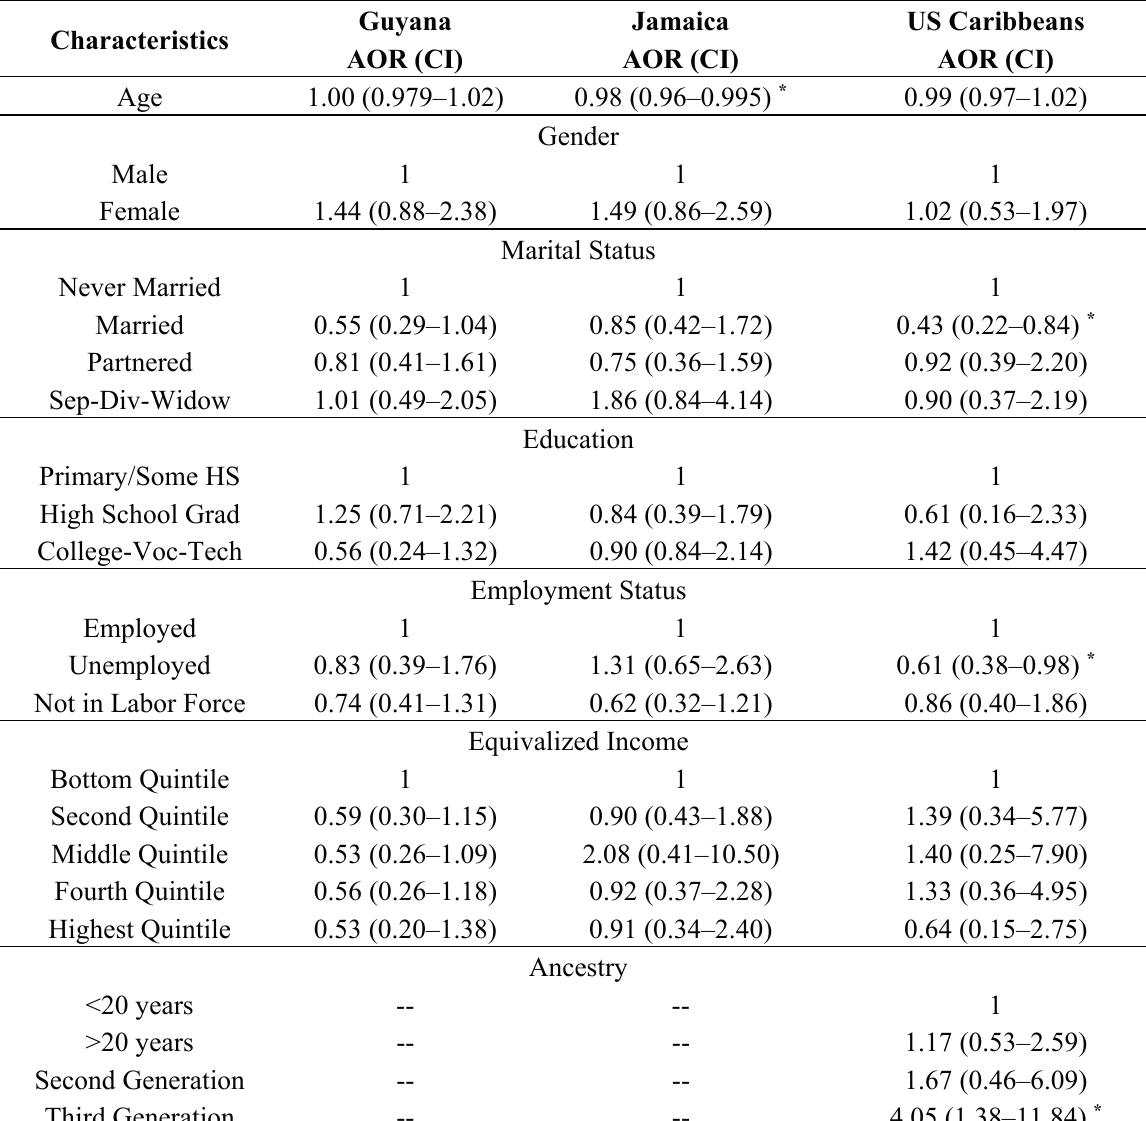
Table 5. Factors associated with lifetime prevalence of major depressive disorder by